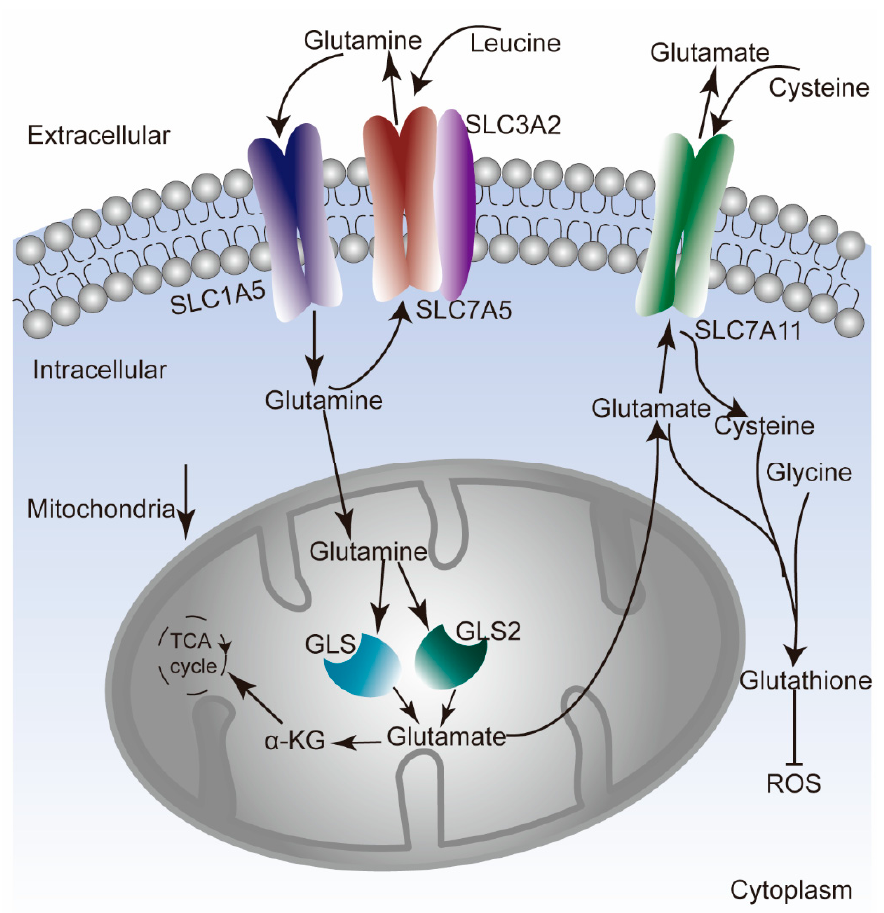
Figure 1. The main pathways of glutamine uptake and catabolism.